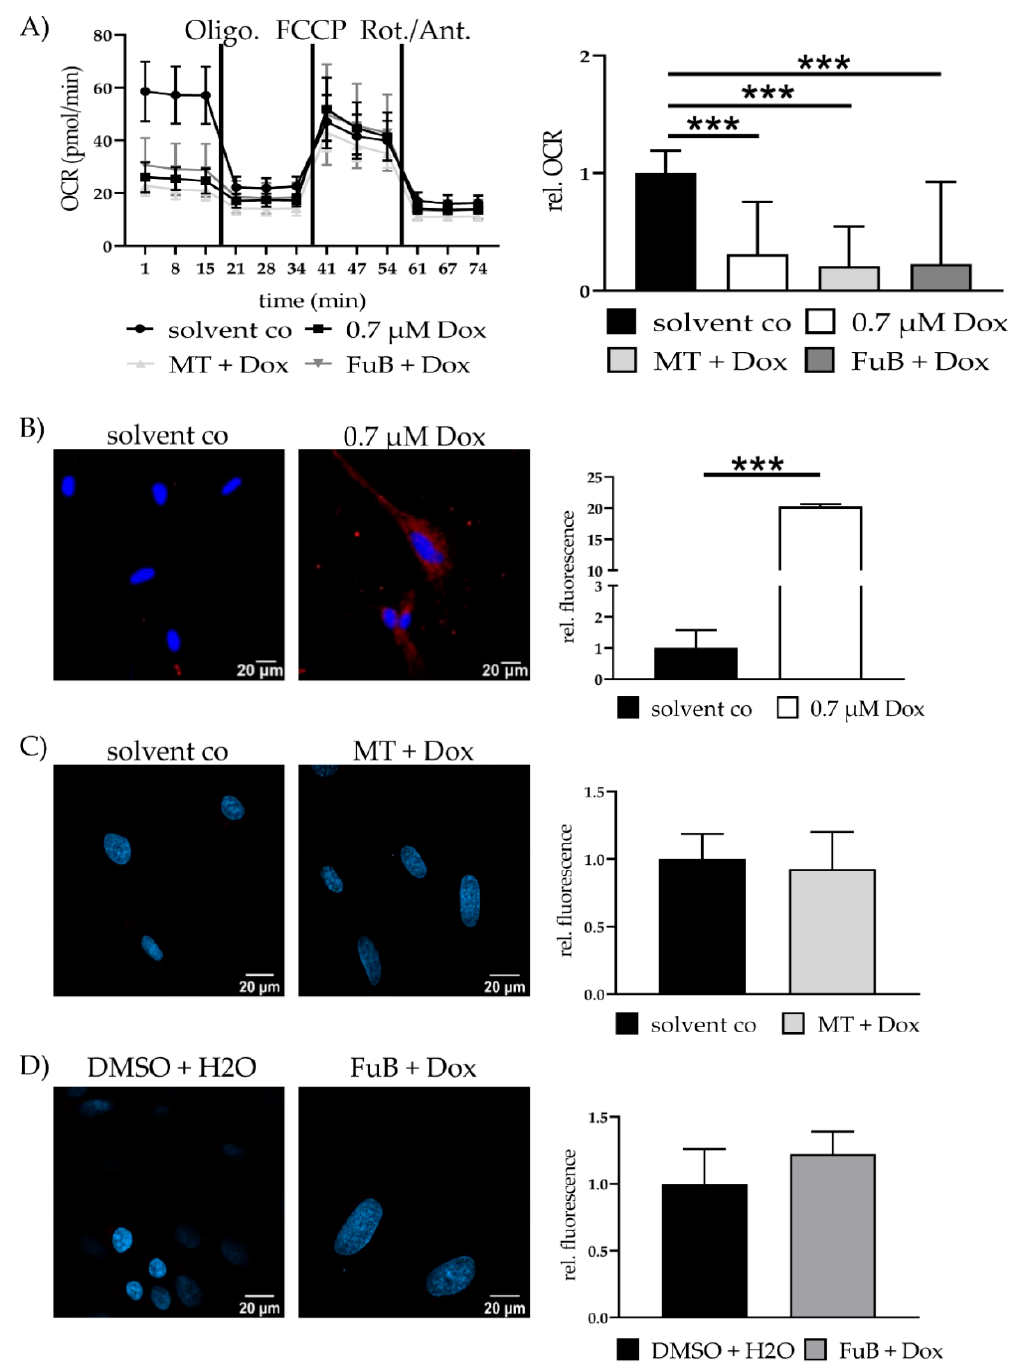
Figure 3. Mitochondrial activity and cell survival—Metabolic function and apoptosis. ( A ) Mitochondrial ATP production measured with Seahorse Analysis. Depictured is one representative measurement. ( B ) Cytochrome c delocalization from mitochondria to cytoplasm visualized with IF. Cytochrome c was stained red. Nucleus was stained blue. Shown are two representative images. ( C ) Cells were pre-treated with MT followed by Dox. Cytochrome c was stained red. Nucleus was stained blue Shown are two representative images. ( D ) Cells were pre-treated with FuB followed by Dox. Cytochrome c was stained red. Nucleus was stained blue. Shown are two representative images. Depicted are mean values and standard deviation of minimum three biological replicates. Significances were calculated with a t -test. (*** p ≤ 0.001).